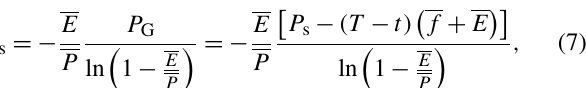
Figure 3. Initial soil moisture content ( θ i ) versus time of wetting- front arrival ( T w ) at 15cm depth for a loamy sand soil. Dots are simulated results from HYDUS-1D simulation, and lines are the exponential model given in Eq. (8), fitted for each rainfall rate, P